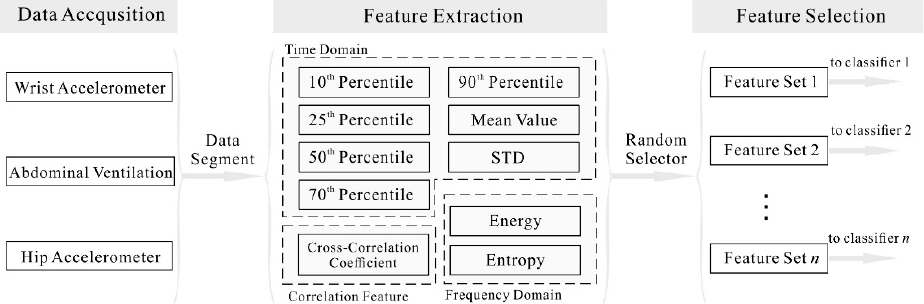
Figure 4. Features extraction and selection.